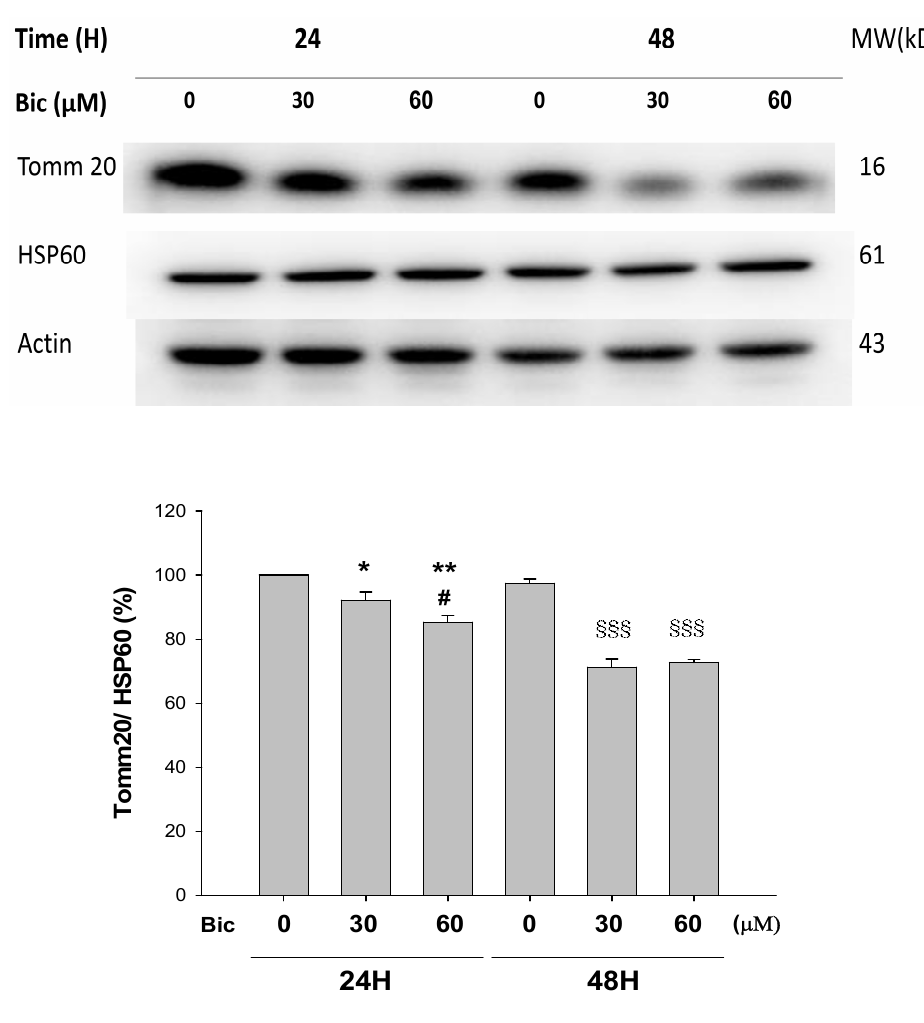
Figure 2. Representative western blot and densitometric analysis showing level of mitochondrial proteins Tomm20 in RMC cells following 0~60 µ M of bicalutamide treatment for 24 and 48 h (HSP60 is shown as normalization control). Bar graph represents the mean ± SD of three independent experiments. * p < 0.05, ** p < 0.01 compared to Bic 0 µ M at 24 h. # p < 0.05 compared to Bic 30 µ M at 24 h. §§§ p < 0.001 compared to Bic 0 µ M at 48 h.